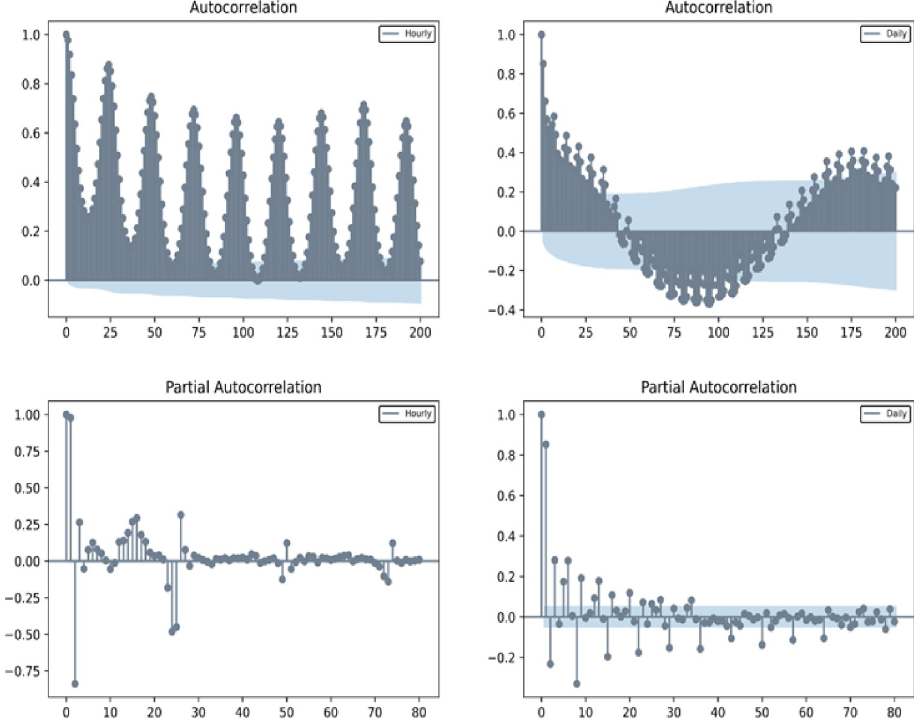
Fig 5. ACF and PACF of electricity consumption per hour and